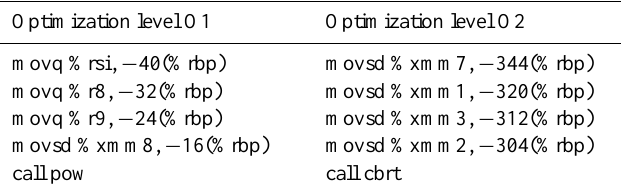
Table 16. Assembly codes of the calculation at line 330 in Fig. 2 in two compiler optimization levels ( O1 and O2 ). The most significant difference of the assembly codes is the calling of different power functions.